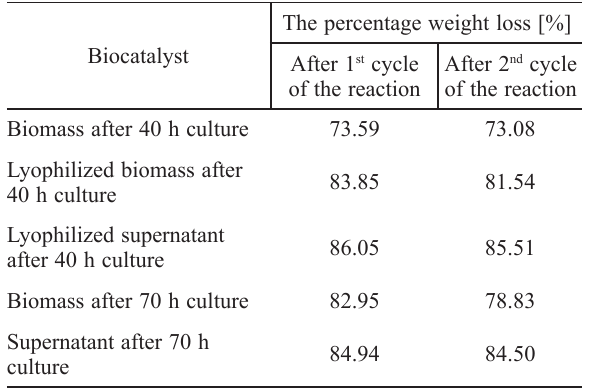
Table 3 – T he percentage weight loss of alginate beads during two subsequent hydrolysis reactions in rela-